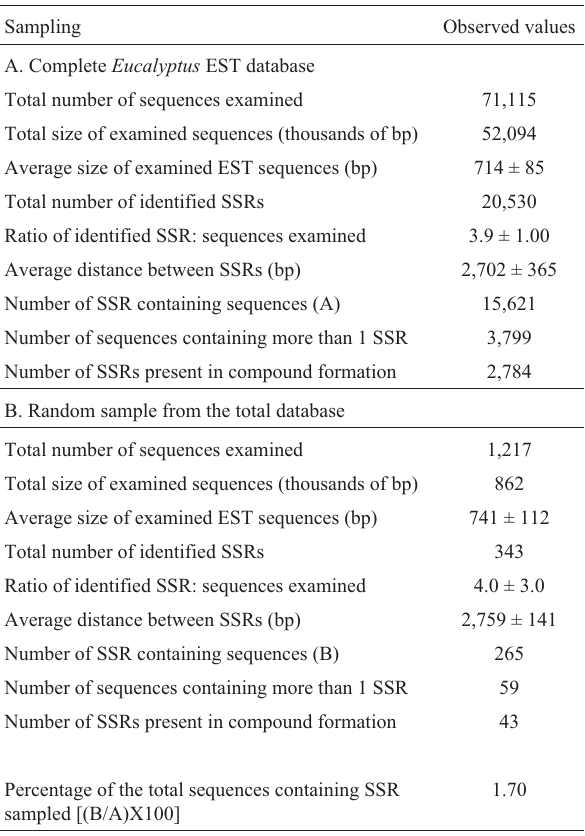
Table 1 - MISA statistics of both complete and random sampling from the Eucalyptus EST FORESTs